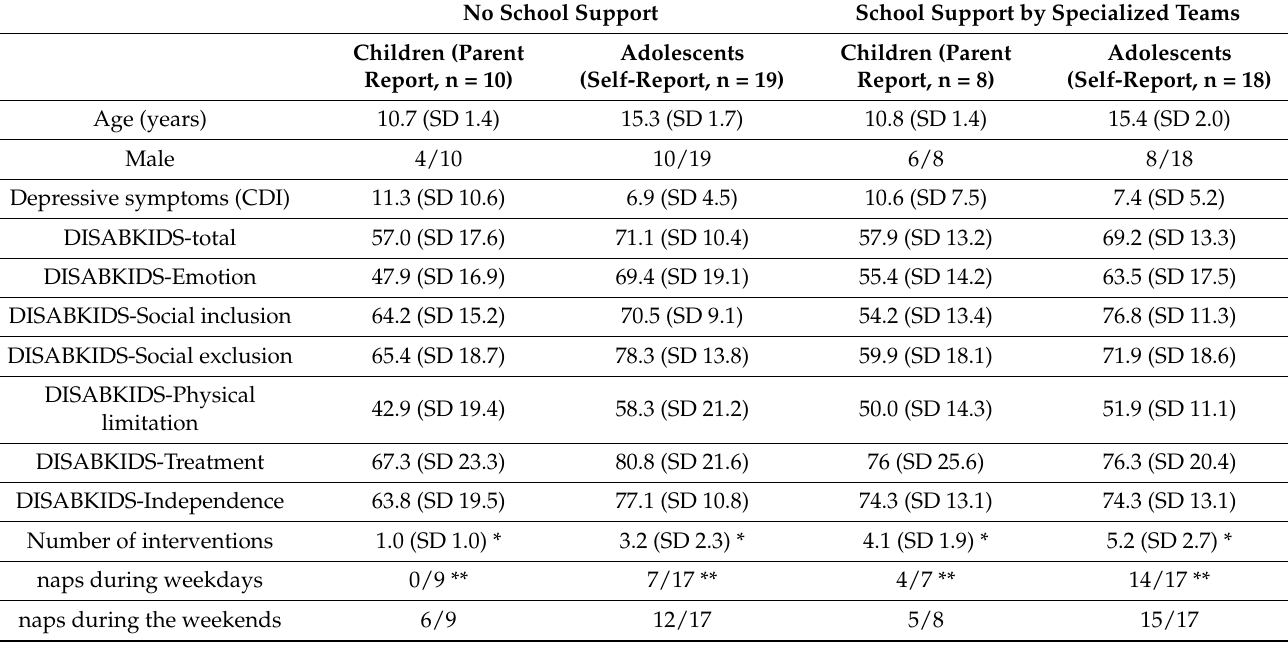
Table 5. The association between school support and school functioning, general functioning and the number of interventions